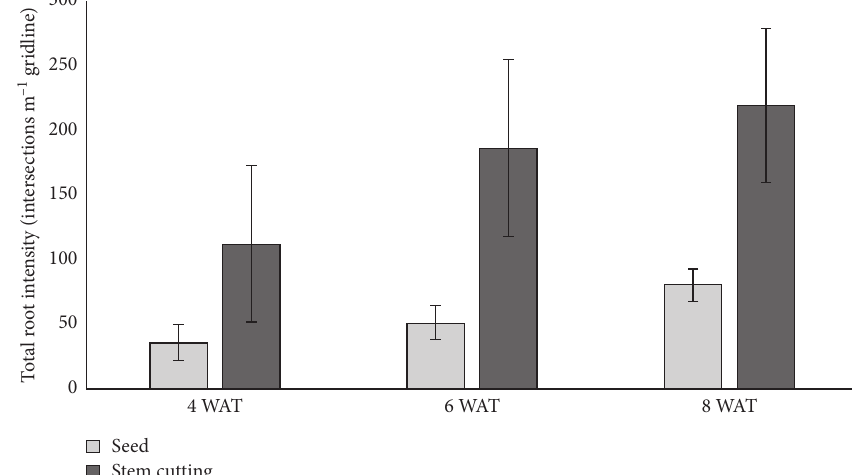
Figure 6: Total root intensity (intersections m − 1 gridline) of E. pellita seedlings from seeds and stem cutting plant materials at three selected dates of root measurement (4, 6, and 8 weeks after transplanting, WAT). The mean values tested using independent samples t -test and statistically the mean values were different ( P < 0 . 05). Bars represent standard deviations of the mean, n � 36 (4 WAT), n � 24 (6 WAT), and n � 12 (8